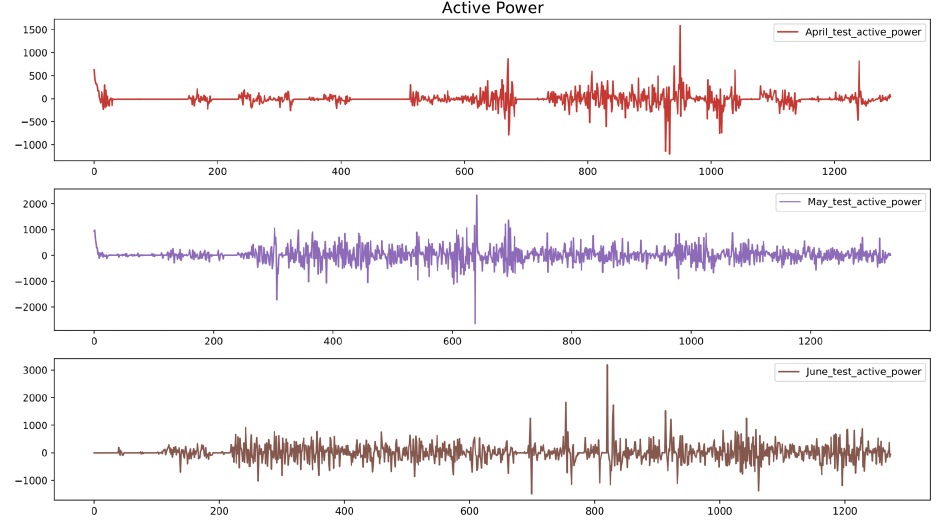
Figure 19. The difference between the actual and predicted value of active power generation over the test set of April, May, and